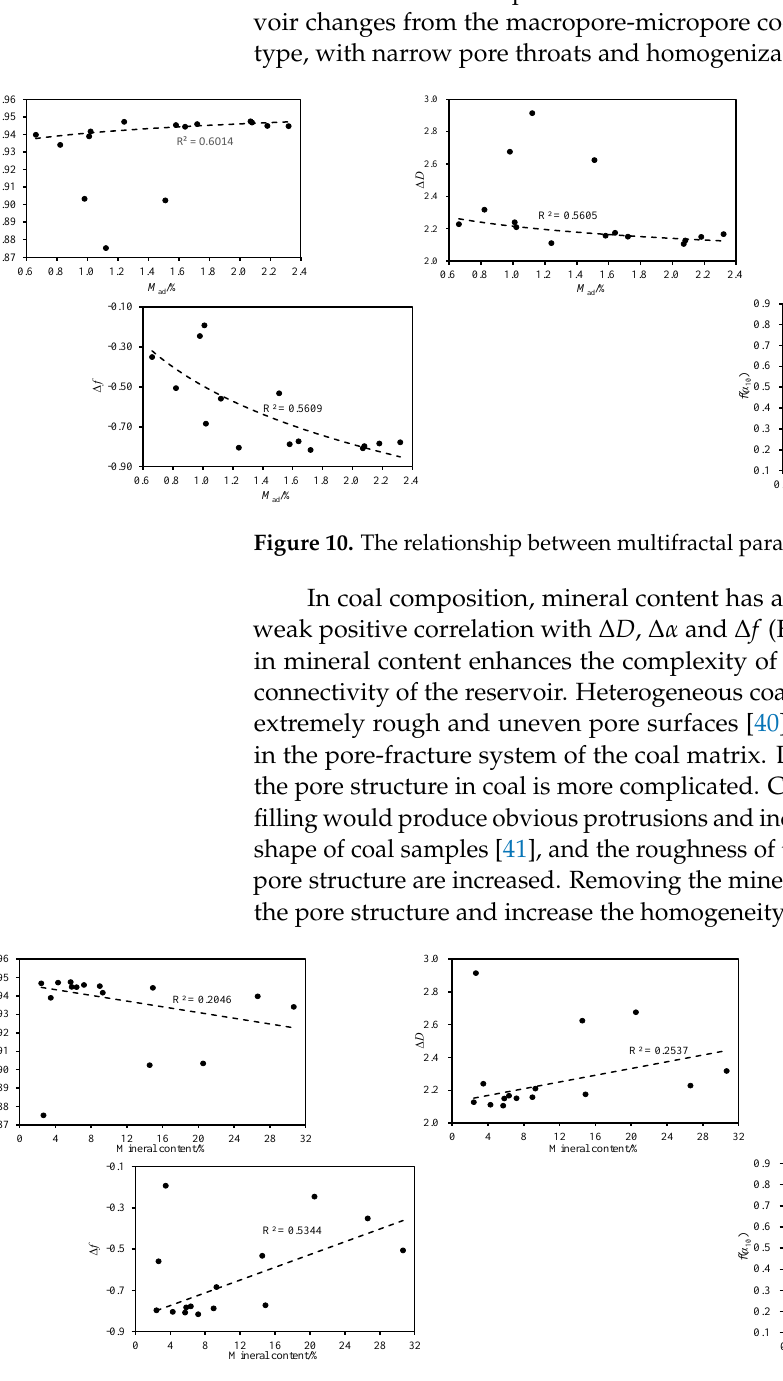
Figure 11. The relationships between multifractal parameters and mineral content. To more clearly reveal the relationship between the coal macerals and the heteroge- neity of pore structure, the correlation between V/I and multifractal parameters was ana- lyzed. With increasing V/I , the overall H of medium-high rank coal increases, while the values of Δ D , Δ α and Δ f decrease(Figure 12). With the increase in V/I , the proportion of homogenous regions in the pore structure of medium-high rank coal increases and grad- ually dominates, while the proportion of heterogeneous regions decreases, and the pore structure tends to be homogenized; that is, compared with inertinite-rich coal, vitrinite rich coal has lower heterogeneity and better pore connectivity. This is because the mi- cropore size difference of coal is small, and the difference in micropore volume depends on vitrinite content [42] . This result is similar to that of Lin et al. [43].